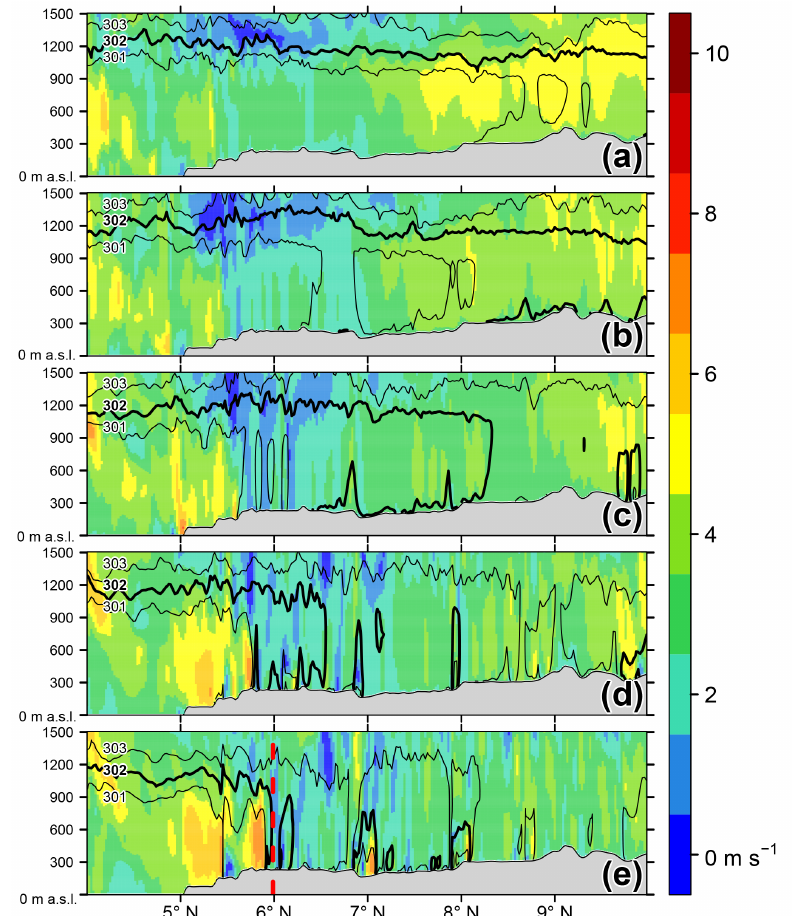
Figure C1. Meridional–vertical transects (ma.s.l.) of wind speed (shading,ms − 1 ) along 5.75 ◦ W (central Ivory Coast) for 2 July (a) 11:00UTC, (b) 12:00UTC, (c) 13:00UTC, (d) 14:00UTC and (e) 15:00UTC for the reference case. The solid black contours show the potential temperature for 301, 302 and 303K, while the bold isentrope (302K) is used for the identification of the AI front (vertical red dashed line in e ). The gray shading indicates the